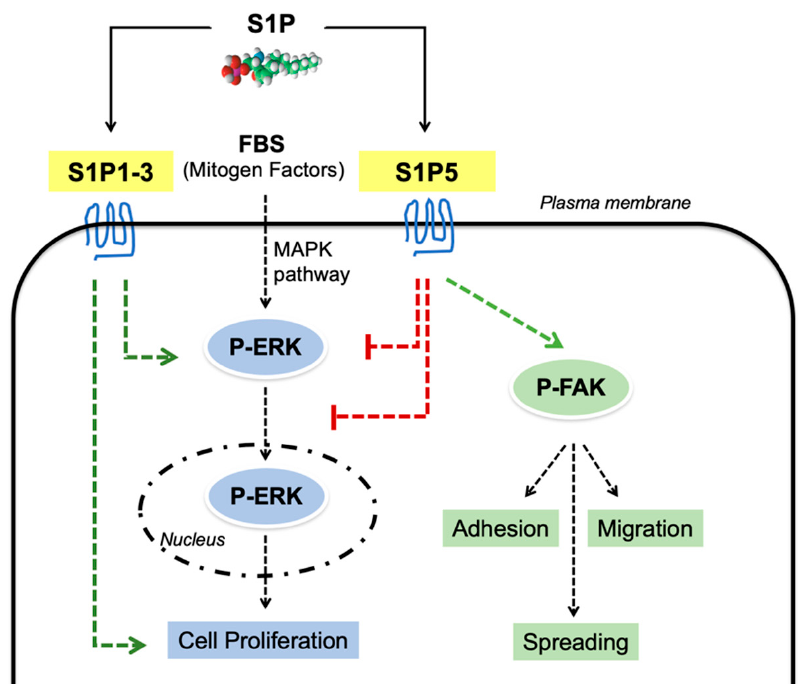
Figure 9. Model of S1P5 function in MEF cell proliferation, spreading and migration. Extracellular S1P (i) decreases FBS-induced ERK activation and subcellular localization via S1P5, (ii) promotes cell proliferation via S1P1-3, and (iii) induces FAK phosphorylation, resulting in cell adhesion, spreading, and migration.